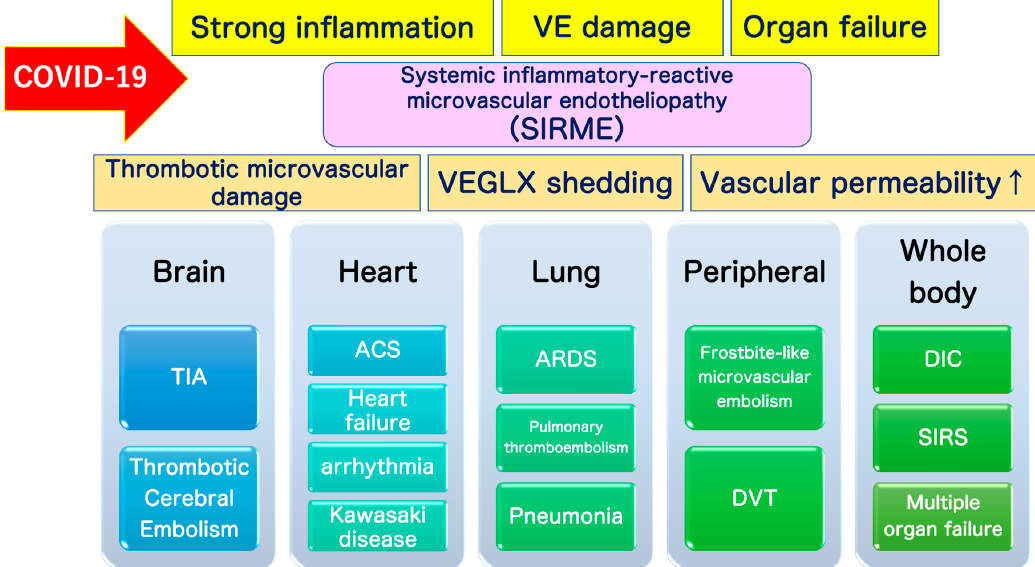
Table 1. SIRME and progressive